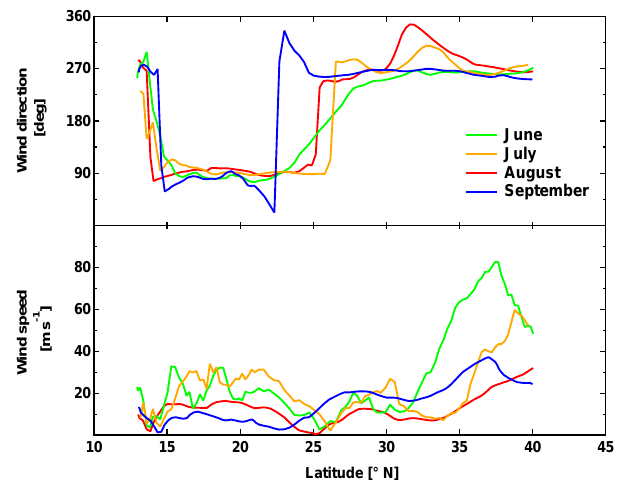
Figure 3. Latitudinal profiles of wind direction (top panel, 90 ◦ means wind from the east, 180 ◦ from the south, 270 ◦ from the west) and wind speed (bottom panel) at aircraft cruise altitude for the first flight from Frankfurt to Chennai in each of the four mon- soon months.